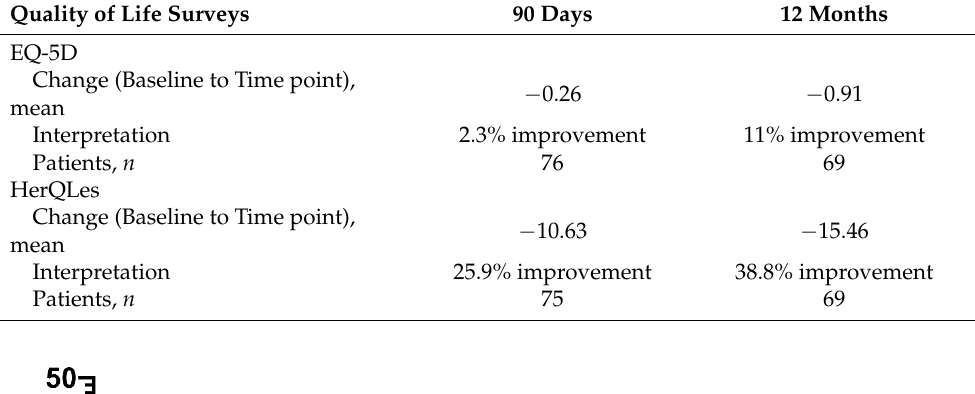
Table 5. Secondary Endpoints: Quality of Life Surveys.